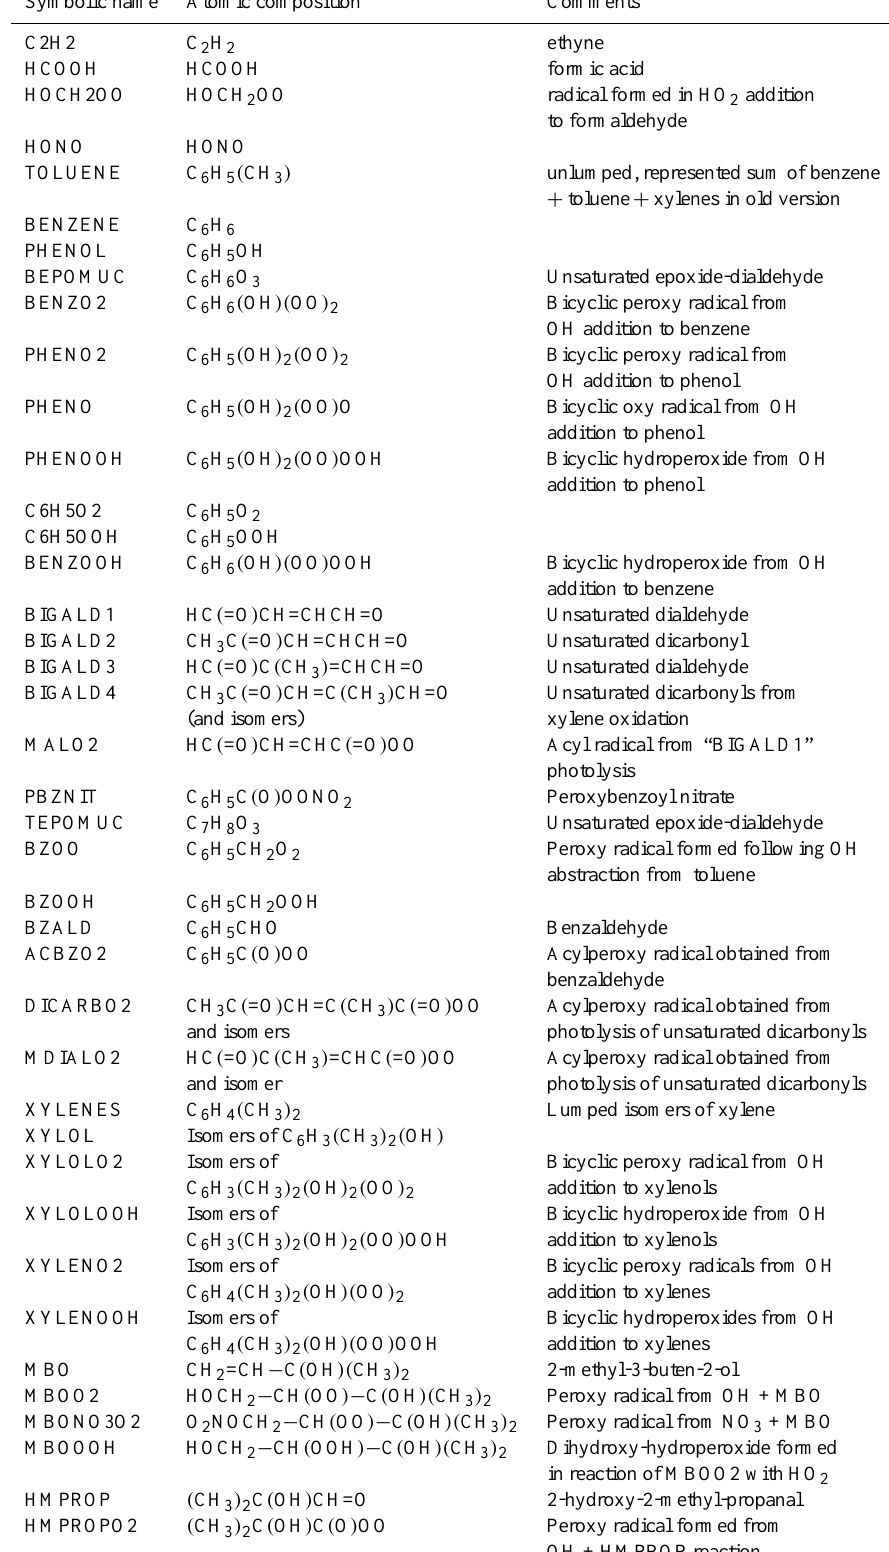
Table 3. New/updated chemical species in